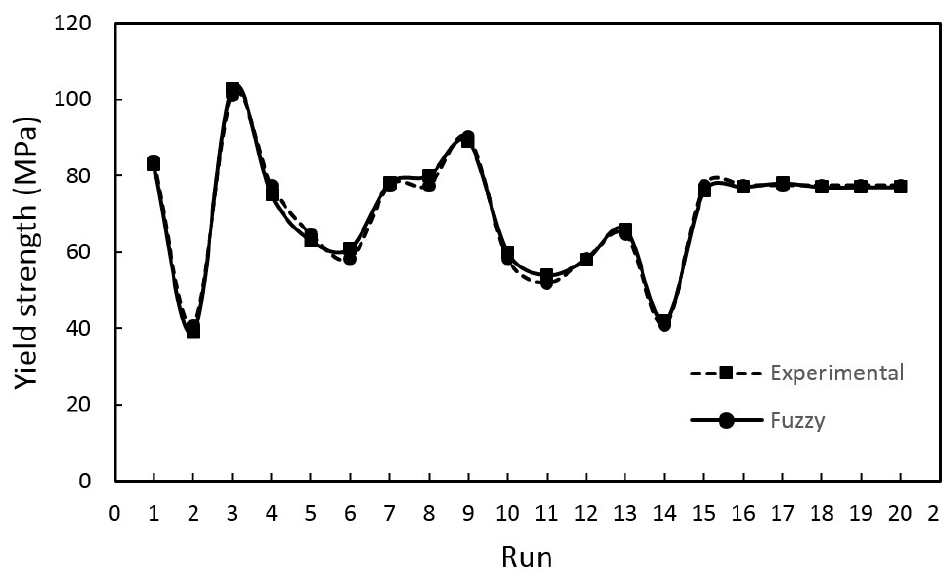
Figure 3. Nano-hardness and fuzzy nano-hardness results.